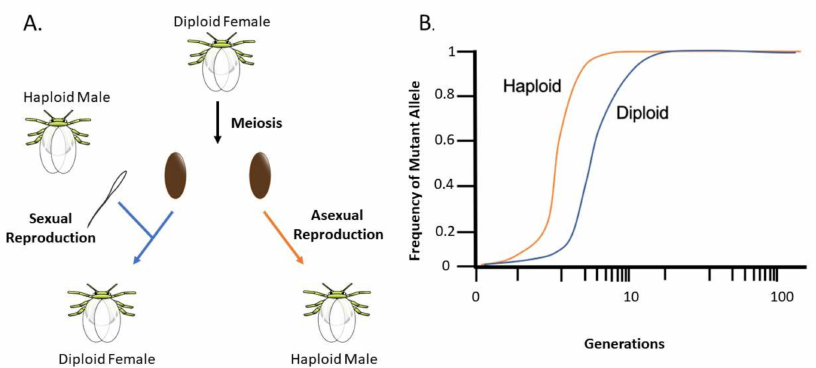
Figure 1. Arrhenotoky in Bemisia tabaci and fixation of resistant alleles. ( A ) Sexual and